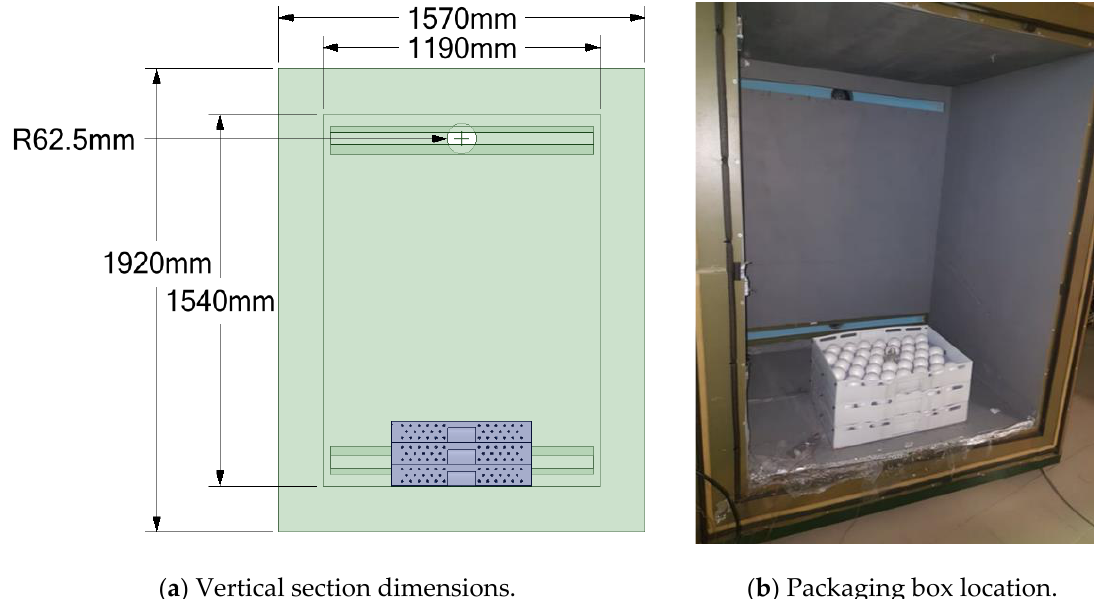
( a ) Vertical section dimensions. ( b ) Packaging box location. Figure 5. Cold Chamber: a) Main dimensions; b) Picture from the beginning of an experiment. Figure 5. Cold Chamber: ( a ) Main dimensions; ( b ) Picture from the beginning of an Table 1. Properties of the materials.